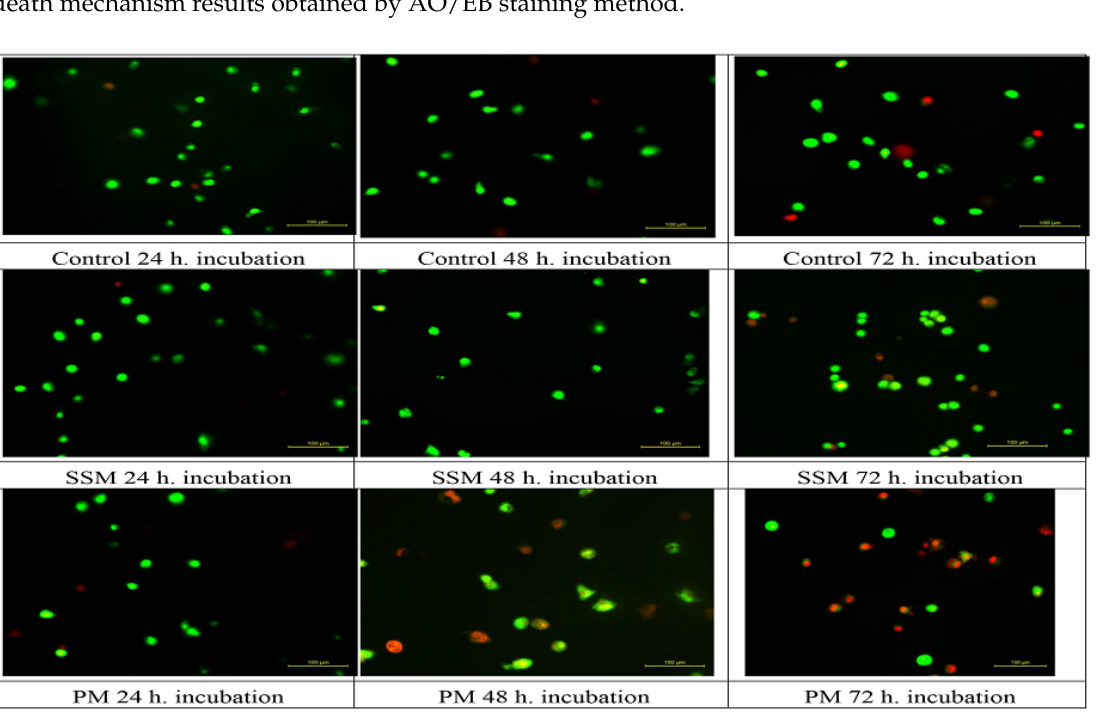
Figure 8. Apoptotic and necrotic activity of SSM and PM on L-929 cell lines. Cells were treated with different concentrations of SSM and PM for 24 (up, left, a), 48 (up, right, b) and 72 h (below middle, c), AO/EB double staining and measured by fluorimetery. There were positive correlations between